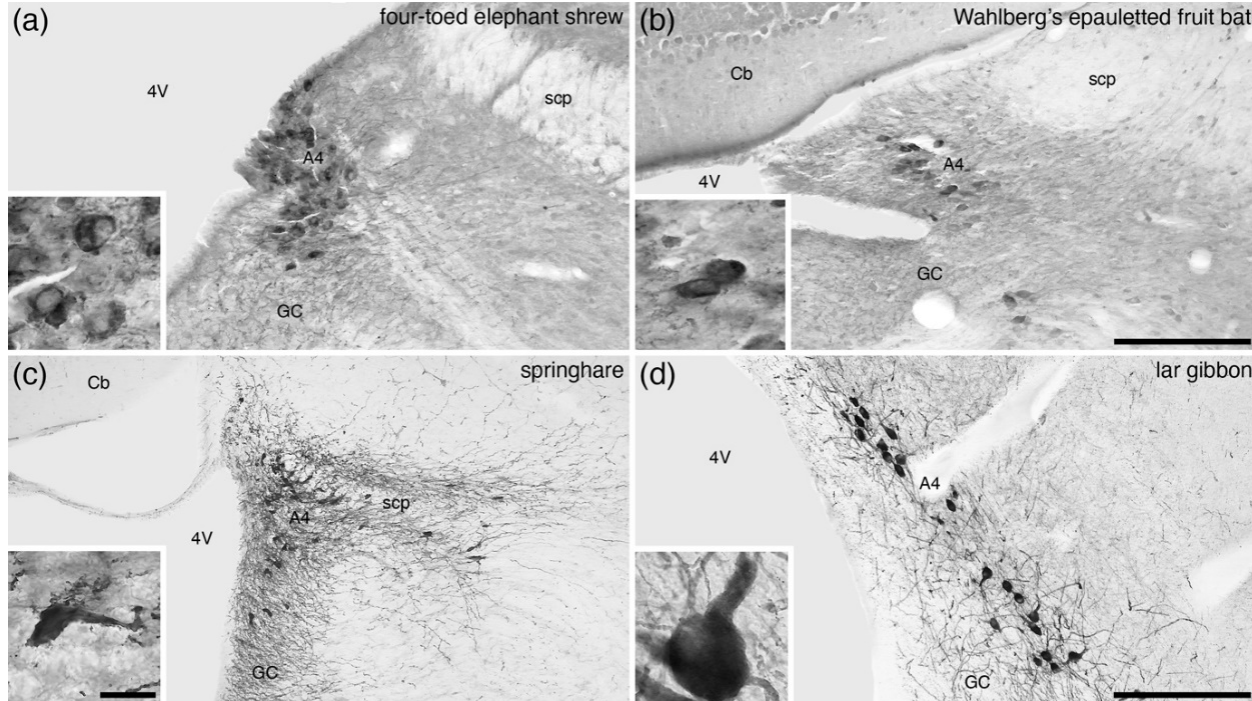
Figure 2. Low-magnification photomicrographs of the dorsolateral division of the locus coeruleus, or A4 nucleus, revealed with immunostaining for tyrosine hydroxylase, in ( a ) the four-toed sengi ( Petrodromus tetradactylus ) [16], ( b ) Wahlberg’s epauletted fruit bat ( Epomophorus wahlbergi ) [24], ( c ) the springhare ( Pedetes capensis ) [44], and ( d ) the lar gibbon ( Hylobates lar ) [58]. Note that across mammalian species this nucleus has a varied occurrence (Table 1), but when present is consistently located in the same location, that being dorsal to the locus coeruleus proper (A6) within the periventricular grey matter adjacent to the dorsomedial-most part of the superior cerebellar peduncle and cerebellar white matter. Insets in each image show a high-magnification image of the neurons that form the A4 nucleus in each species. In all images, dorsal is to the top and medial to the left. Scale bar in ( b ) = 250 µm and applies to ( a , b ). Scale bar in ( d ) = 500 µm and applies to ( c , d ). Scale bar in inset ( c ) = 25 µm and applies to all insets. 4V —fourth ventricle; Cb —cerebellum; GC —periventricular grey matter of the rostral hindbrain; scp —superior cerebellar peduncle.